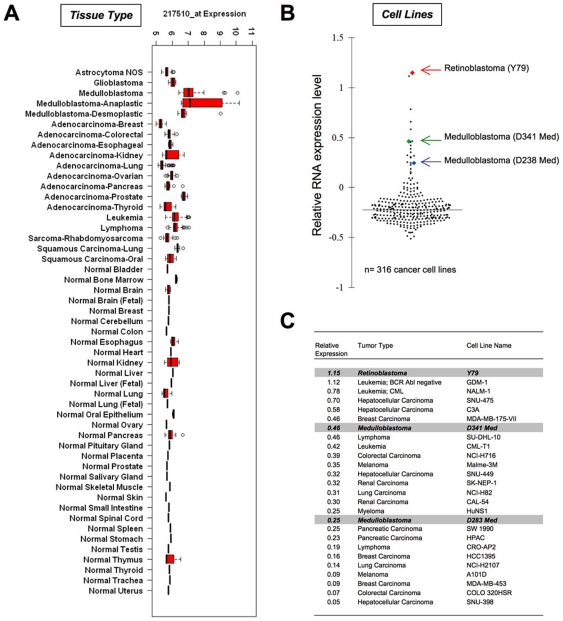
Expression profiling analysis demonstrates CRX expression is highly lineage-restricted across a broad range of cancer tissues and cell lines.Analysis of CRX mRNA expression was assessed using publically available expression profiling data from over 1900 primary tumor samples and demonstrates elevated expression of CRX predominantly in medulloblastoma samples (A). Pineal parenchymal tumor data is not available. Oncomine data from 316 human cancer cell lines demonstrates 26 lines with significant expression of CRX relative to other lines as demonstrated in a scatter plot (B). All expression levels are relative to the total dataset. The highest relative expression level was present in the sole retinoblastoma cell line (Y79) within the dataset (C). High level expression was also noted in the only two medulloblastoma cell lines present in the dataset (D341 and D283). Other CNS tumor cell lines showed no significant increase in CRX expression (8 astrocytoma, 1 PNET). Additional validation using same independent normalization methods as for tissues produced similar results (Fig. S2). Data utilized in construction of plots is provided as Table S1 and S2.